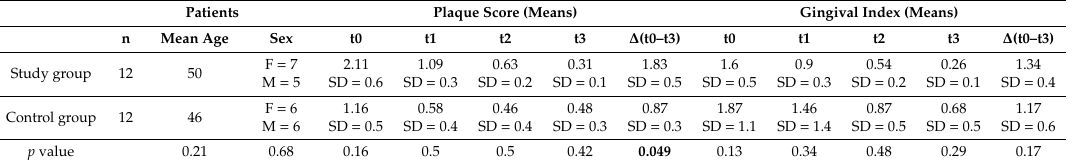
Table 2. Comparison of clinical indexes for test group and control